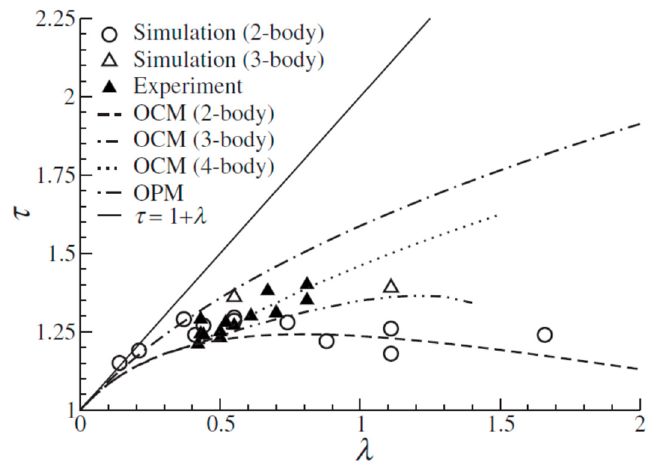
Figure 2. Scaled equilibrium distance τ vs. λ . When the surface ligands do not overlap each other, τ = 1 + λ . Therefore, as the points or lines are more away from the solid line ( τ = 1 + λ ), it indicates more overlapped surface ligands. (Reproduced with permission from [20]. Copyright American Institute of Physics, 2009). OCM: Overlap cone model. OPM: Optimal packing model.